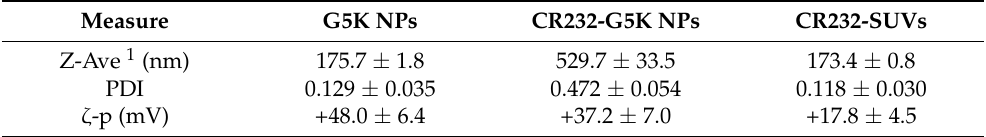
Table 7. Results obtained from DLS analyses on G5K NPs, CR232-G5K NPs, and CR232-SUVs: particle size (Z-ave, nm), PDI and ζ